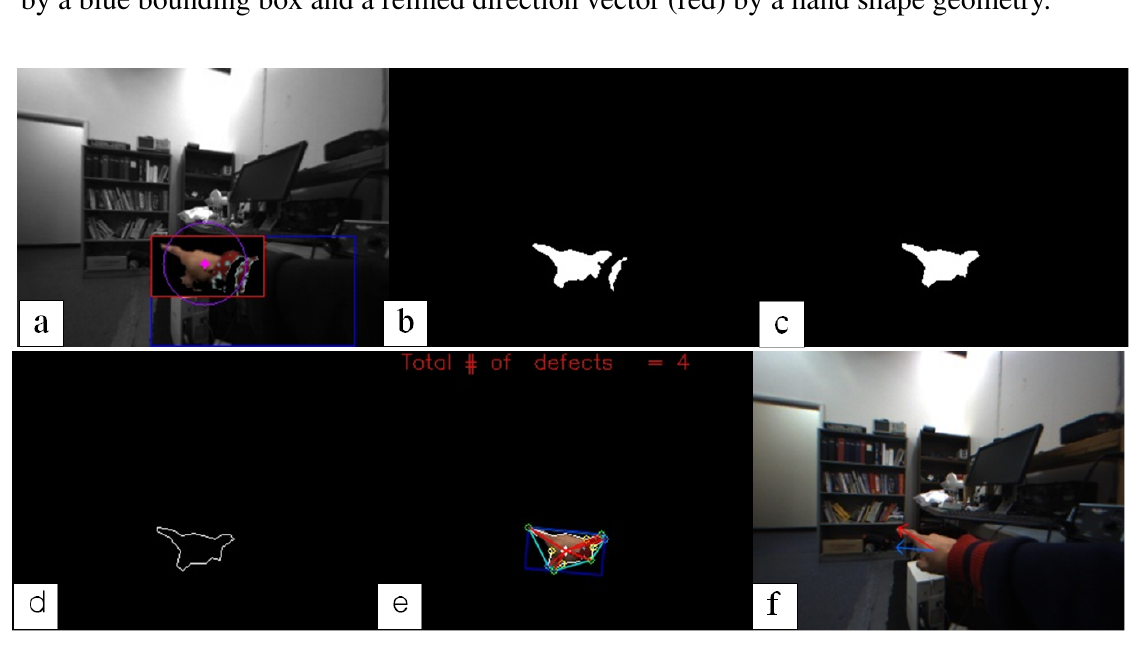
Figure 3. Photographic representation of estimating a 2D pointing direction: ( a ) a detected hand area; ( b ) the binary image of ( a ) but with noises; ( c ) a cleaned hand region after removing noises by using a connected component analysis; ( d ) the hand contour; ( e ) a hand shape estimated by an geometric analysis; and ( f ) an initial estimated direction vector (blue) by a blue bounding box and a refined direction vector (red) by a hand shape